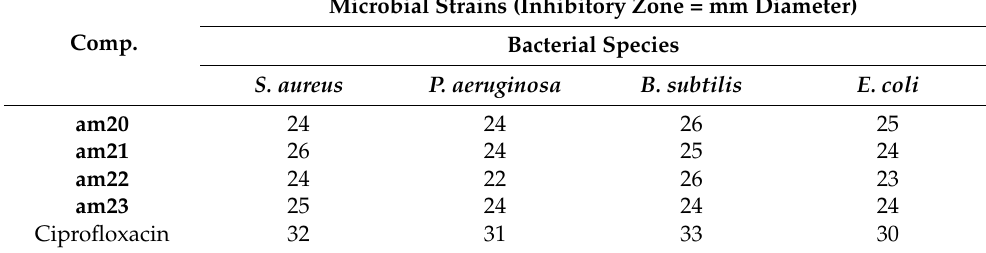
Table 11. Antimicrobial screening results (inhibitory zone = mm diameter) of the compounds ( am20 – am23 ).